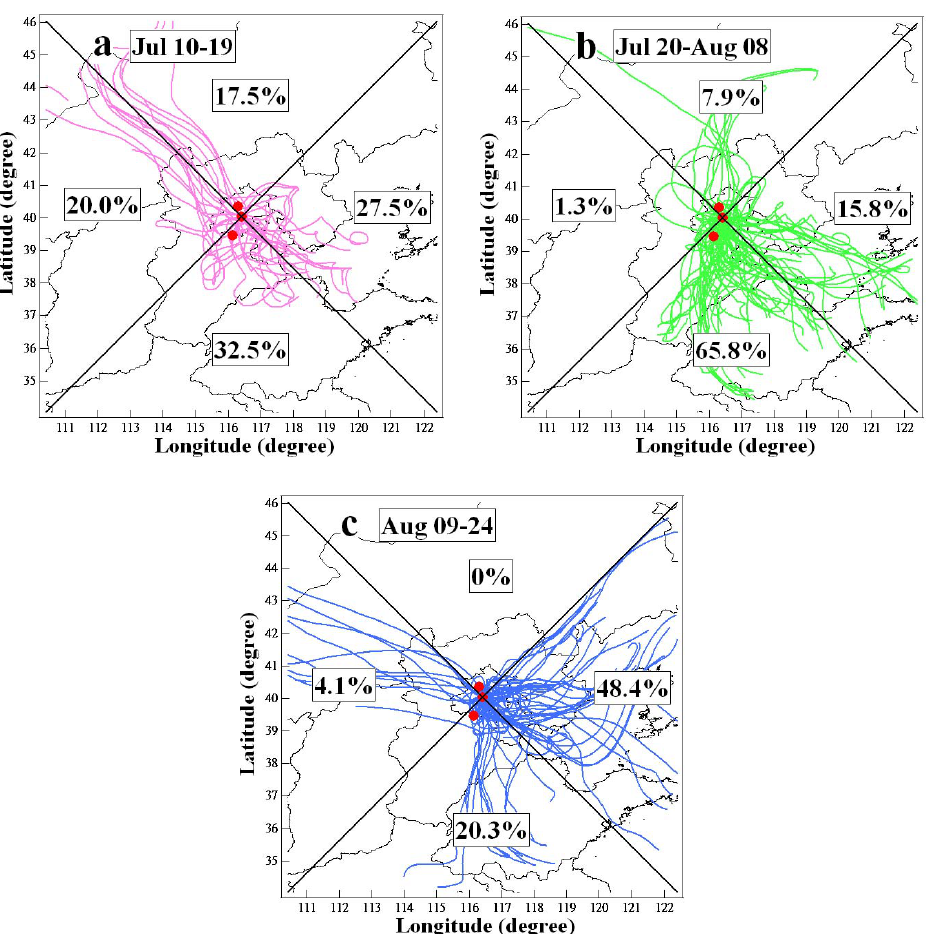
Fig. 5. Forty-eight hour backward trajectories during (a) 10–19 July (b) 20 July–8 August and (c) 9–24 August. Numbers are the percentage contributions from each of the four sectors. The percentage of non-defined (i.e. looping) trajectories is 2.5%, 9.2% and 27.2% for period 1, 2 and 3, respectively. The red points are the locations of the XCC, CRAES, and HSZ